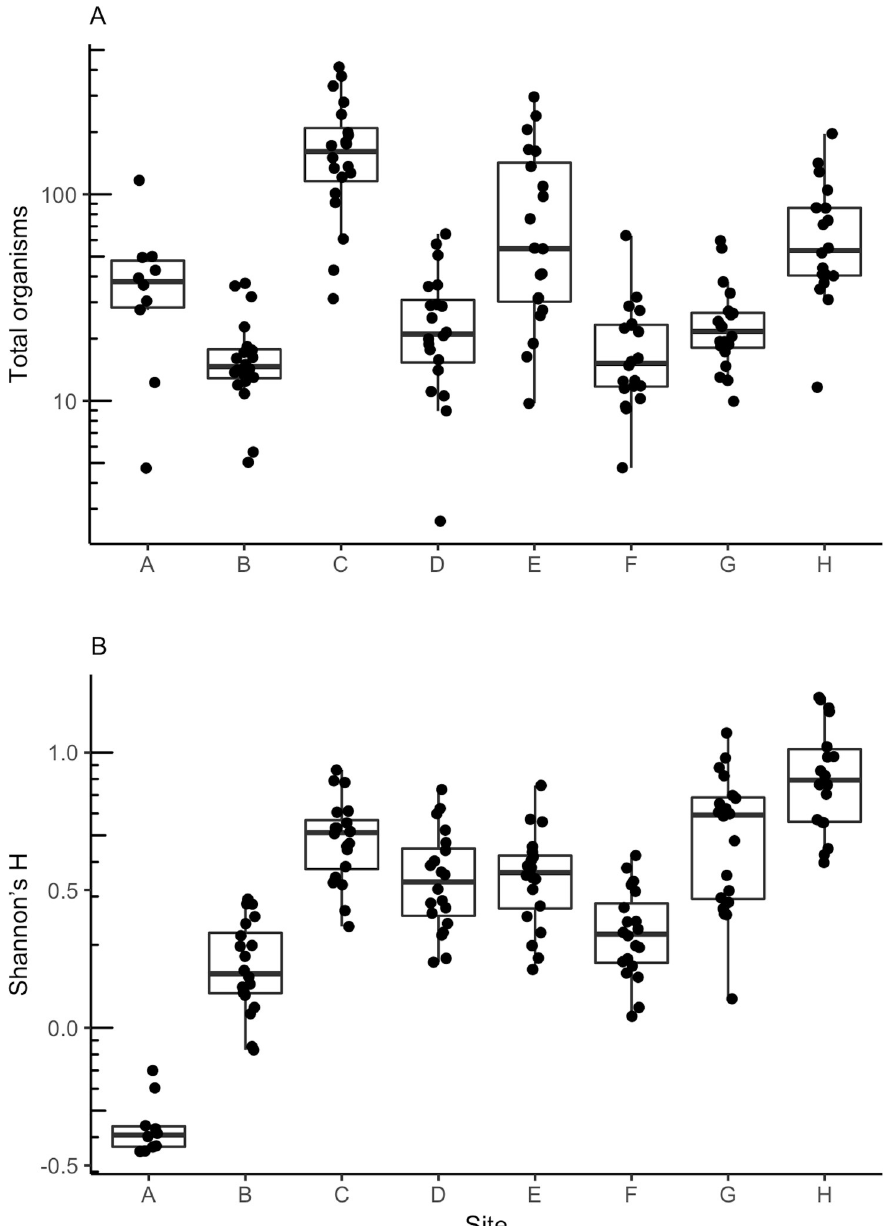
Fig 3. Communities within pitchers varied among plant populations. A) Total inquiline organisms and B) Shannon’s H for each of eight sites sampled in July 2015. Populations are ordered from fewest plants (site A) to most plants (site H) and rank order of isolation is provided in Table 1. Boxplots and points are least square means-adjusted values. Site means were obtained for A and B from models c and i , respectively, and residuals were obtained from models e and k , respectively, in Table